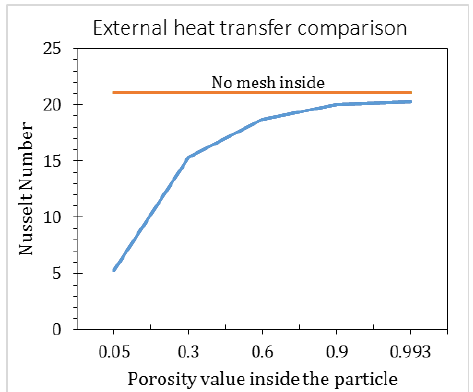
Figure 3. Nusselt number extracted on 25 planes based on local driving force [18,21,42,43] versus porosity value inside the particle. The comparison is made to Nusselt number from the ideal external heat transfer case without inside particle mesh. This value has also been verified with Singhal [19] heat transfer correlation.